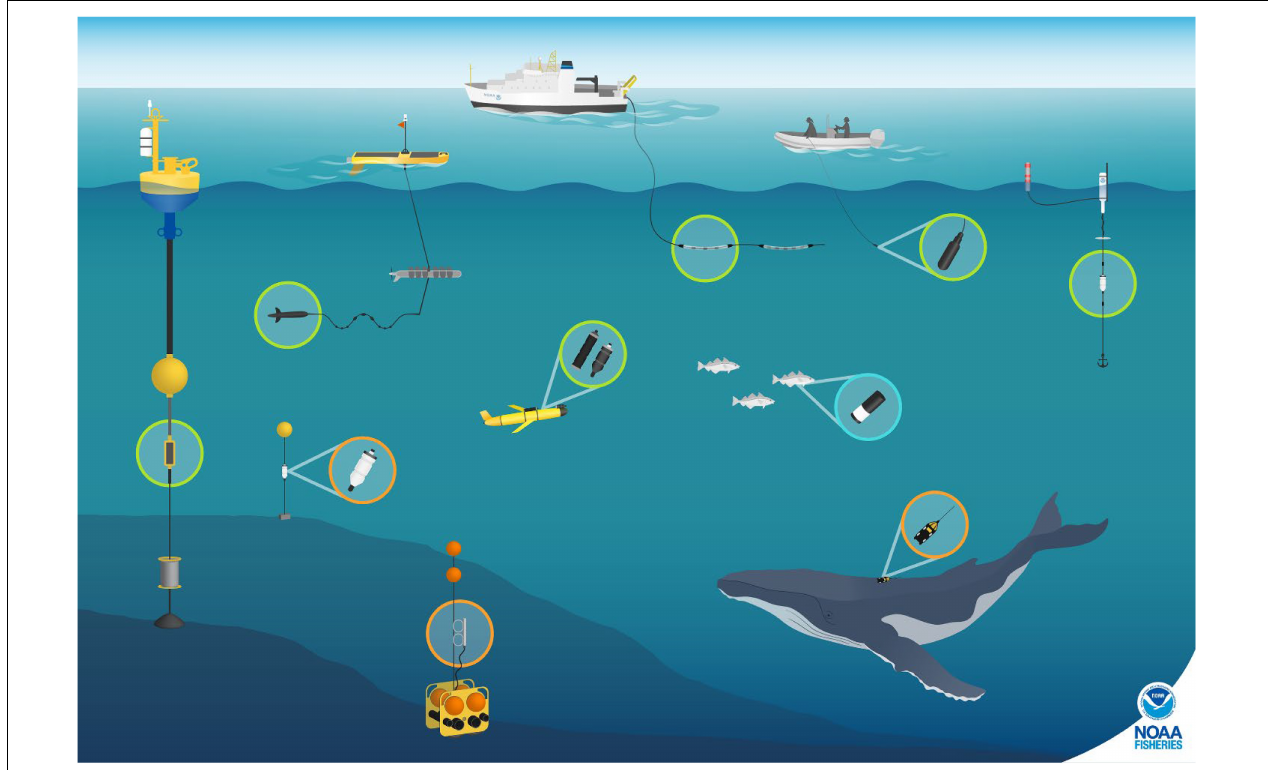
FIGURE 1 | The illustration shows examples of different types of acoustic technologies. From left to right, the illustration shows a moored surface buoy, wave glider, SoundTrap on the seafloor, bottom-mounted acoustic recorder (High-frequency Acoustic Recording Package [HARP]), Slocum glider, NOAA ship towing a hydrophone array, tagged Atlantic cod, humpback whale with an archival tag, drop hydrophone deployed from a small boat, and autonomous, free-floating acoustic recorder (Drifting Acoustic Spar Buoy Recorder [DASBR]). The different technologies are highlighted with colored circles that show a zoomed-in view of the instruments and colors that represent the type of data collected: green for real-time data capabilities, orange for archival data, and blue for active